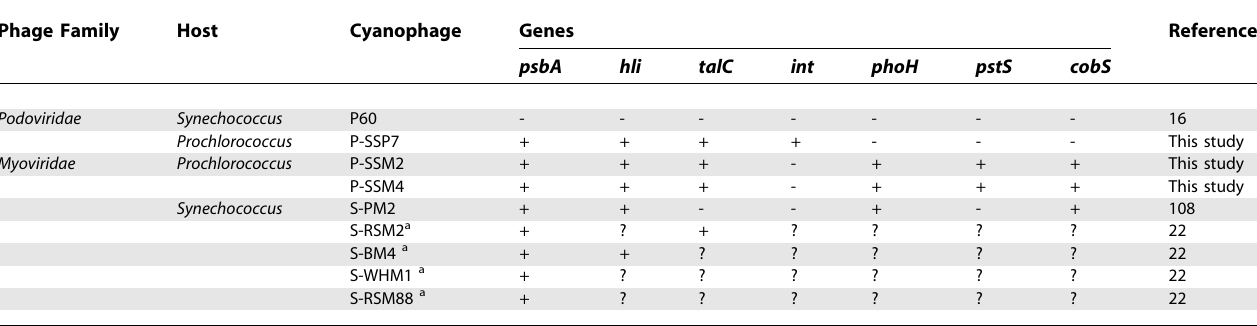
Table 6. Signature Cyanophage